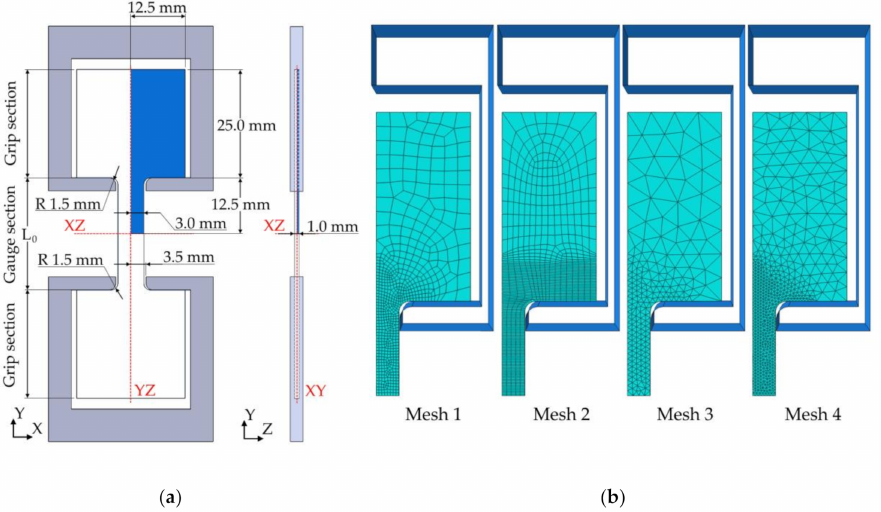
Figure 1. The computer model of tensile test: ( a ) geometry of a specimen; ( b ) Finite element meshes used in the